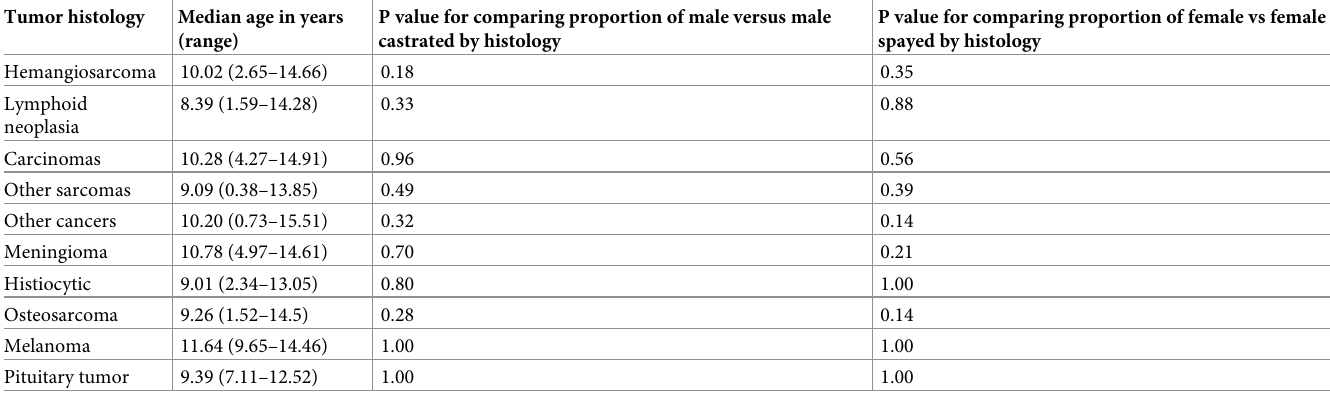
Table 1. Age by tumor histology and comparison of sex groupings. Tumor histology Median age in years